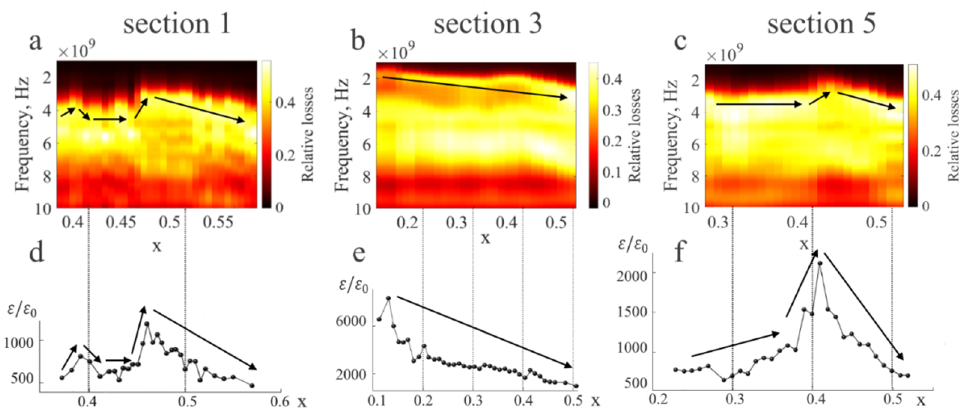
Figure 10. The dependence of the absorption coefficient on the frequency and samples of the 1st ( a ), 3rd ( b ), and 5th ( c ) sections of the system and the dependence of the dielectric constant on the concentration of PT in samples of the same sections ( d – f ). The arrows show correlations.